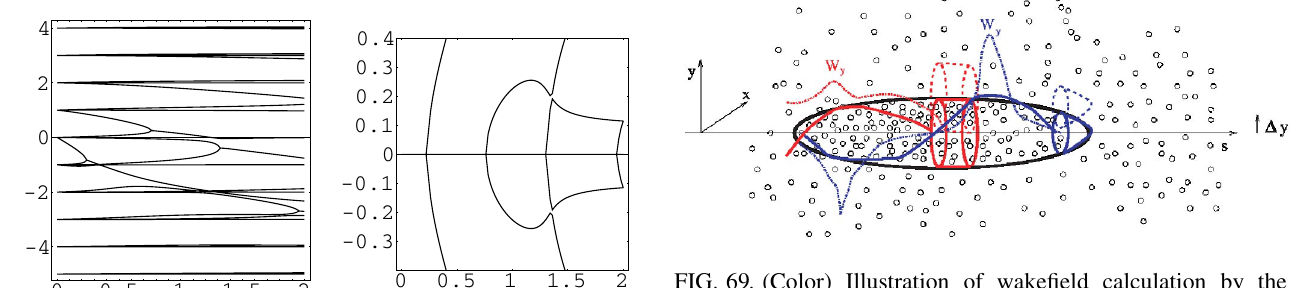
FIG. 69. (Color) Illustration of wakefield calculation by the HEADTAIL code [91]; after displacing a longitudinal bunch slice transversely, either the field on axis or the average force expe- rienced by subsequent slices is computed; normalization to the (cid:3) charge and offset of the displaced slice yields an estimate of the b wake.